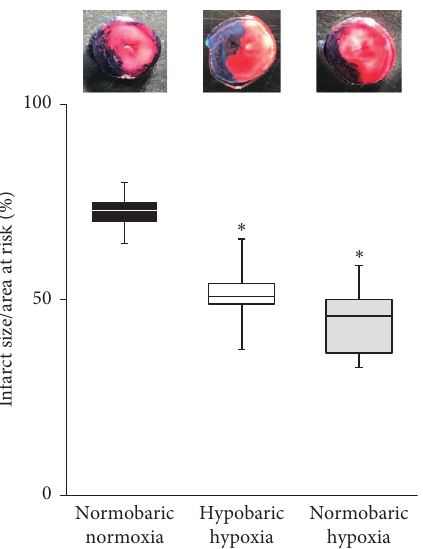
Figure 3: Infarct size/area at risk in the three groups. Represen- tative TTC staining of heart slices after ischemia/reperfusion injury are presented for all groups. Infarct size is presented as a percentage of the area at risk. Data are shown as median and interquartile range (IQR), n � 8 rats per group. ∗ p < 0.01 vs. normobaric nor- moxia group by one-way analysis of variance (ANOVA) followed by Tukey’s post hoc test.